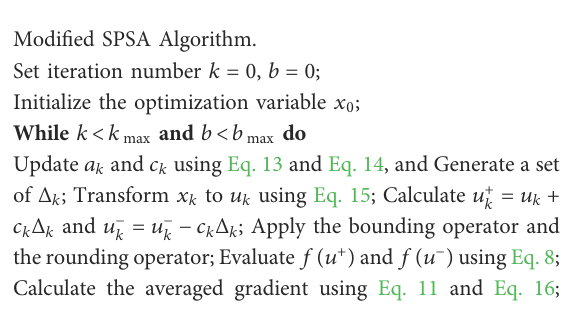
Algorithm 1: Modi fi ed SPSA algorithm for well placement